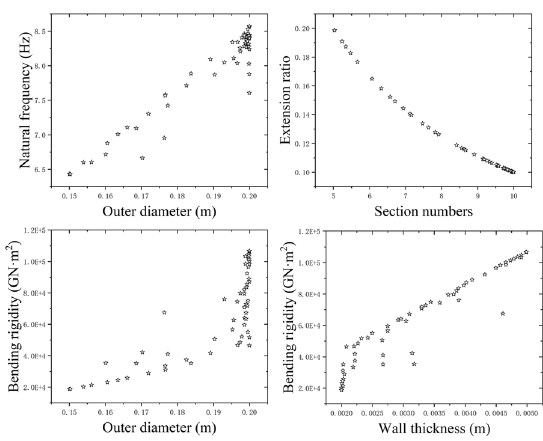
Figure 17 Game process between target and design parameters